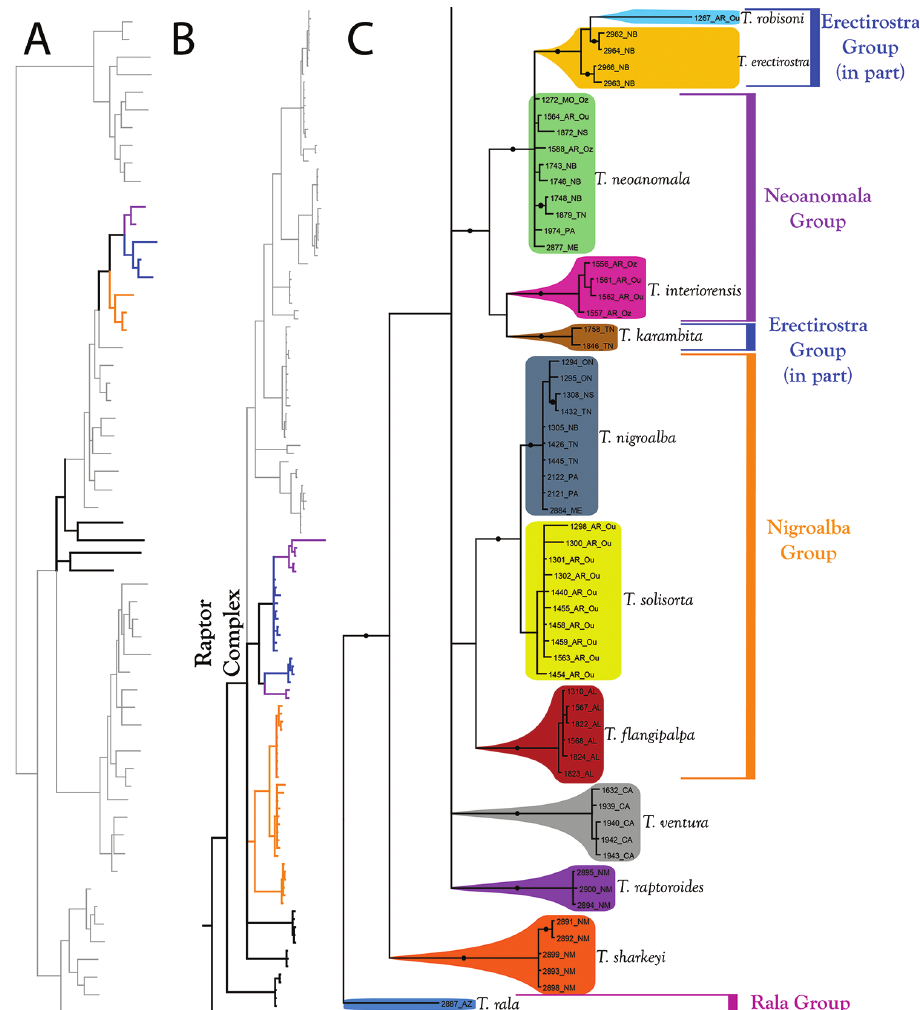
Figure 11. Raptor Complex (part II). Species of the Raptor Complex are eastern, but the species that do not fit into the complex ( T. rala ; T. sharkeyi ; T. raptoroides ; & T. skvarlai ) are western. A Species guide (overview of 28S+COI analysis from Figure 7–8) B Overview of Raptor Complex from Figure 9 (COI- only analysis from Figure 9) C Detail of Raptor Complex (in part) from B. Colored lineages in A and B correspond to Group names and brackets in C. Dots denote posterior probably of greater than 95%. Taxa are displayed by DNA number and state or territory